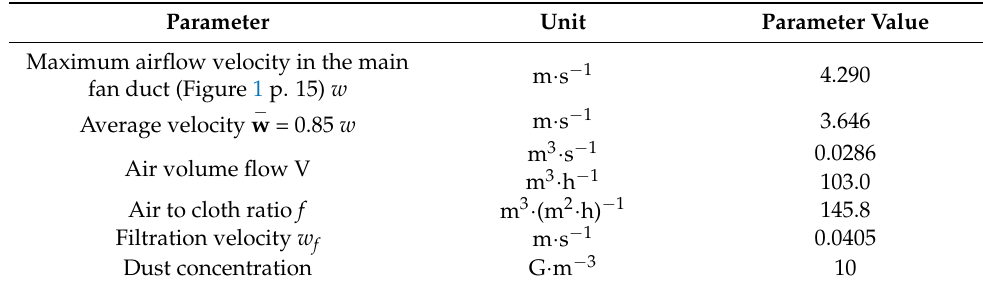
Table 3. Filtration parameters during testing of filtering non-wovens. Parameter Unit Parameter Value Maximum airflow velocity in the main fan duct (Figure 1 p. 15)